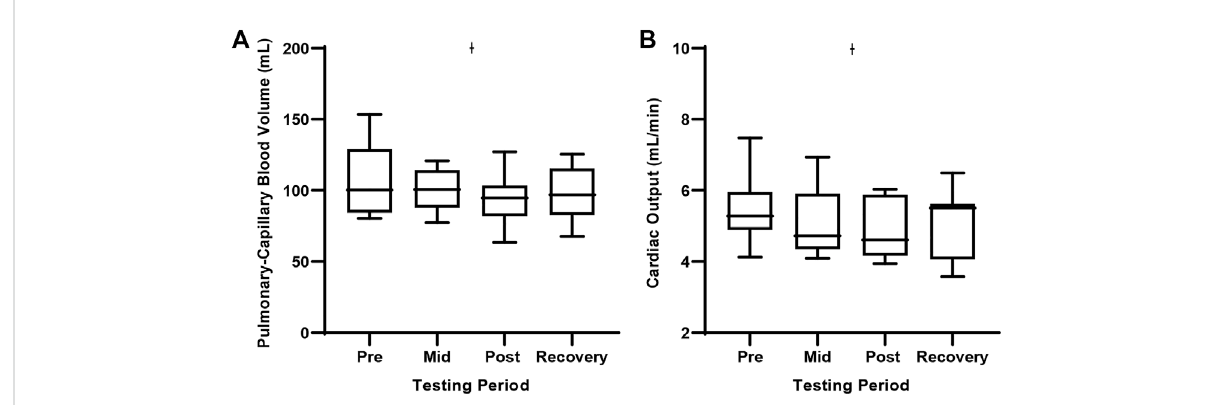
FIGURE 1 Pulmonary-capillary blood volume and cardiac output during the 30 s oscillation exposure. Values represent means ± SD. (A) Depicts pulmonary-capillary blood volume and (B) Depicts cardiac output. Ɨ Signi fi cant difference from the Pretesting period, p < 0.05.